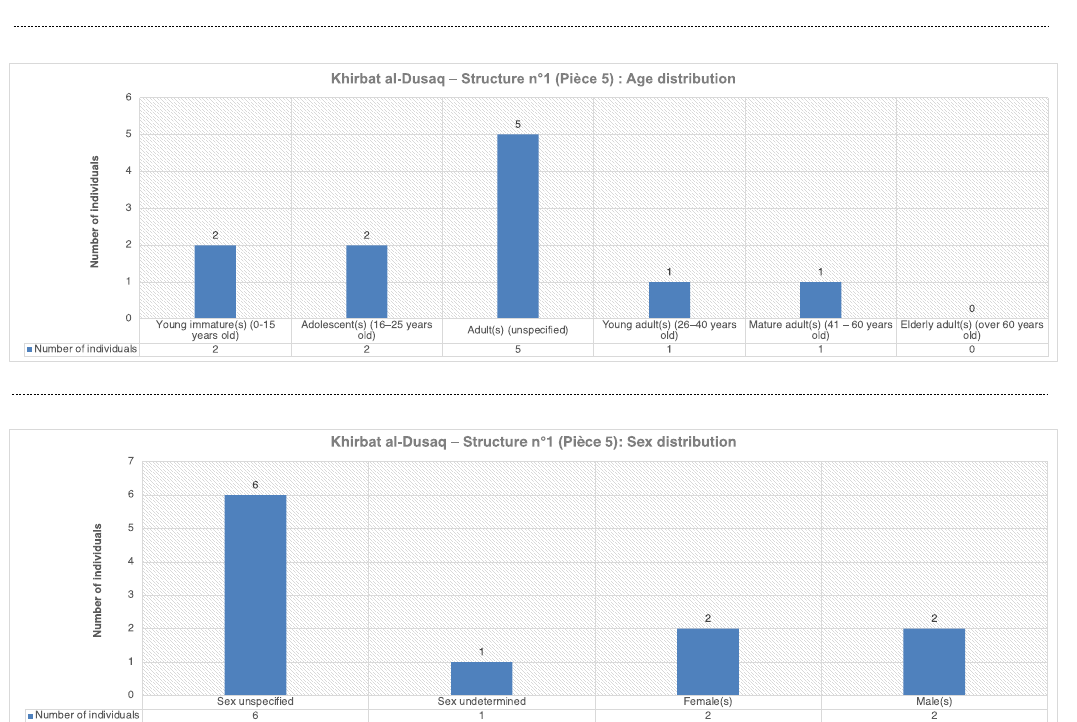
Figure 6: Structure no 1 ( Pièce 5 ) : frequency and exclusion MNI graph ( top ) , age distribution graph ( centre ) , and sex distribution graph ( bottom ) . Figures by Hofstetter ( 2022 )